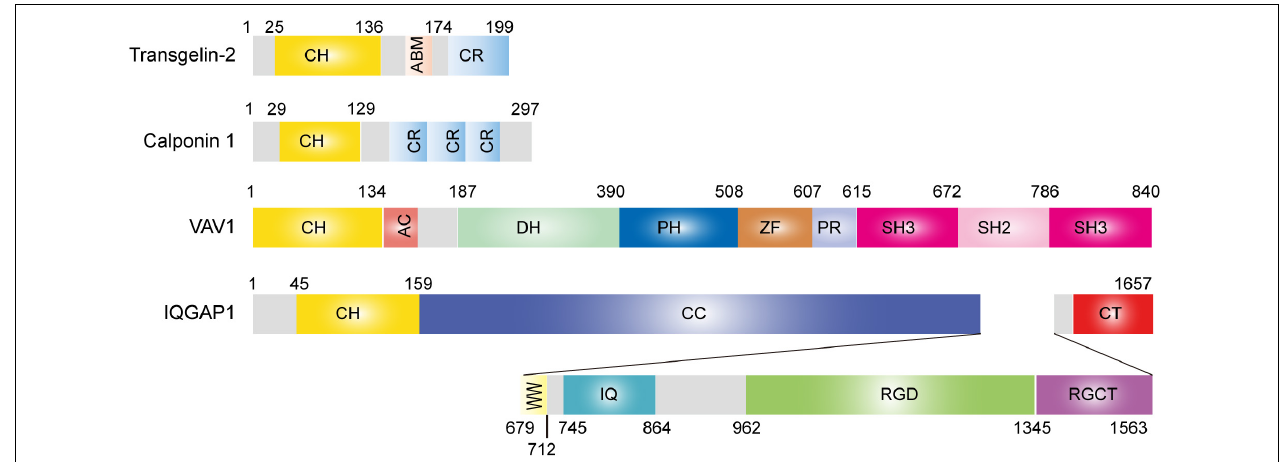
FIGURE 1 | Structure of transgelin-2 and comparison with other single calponin homology domain